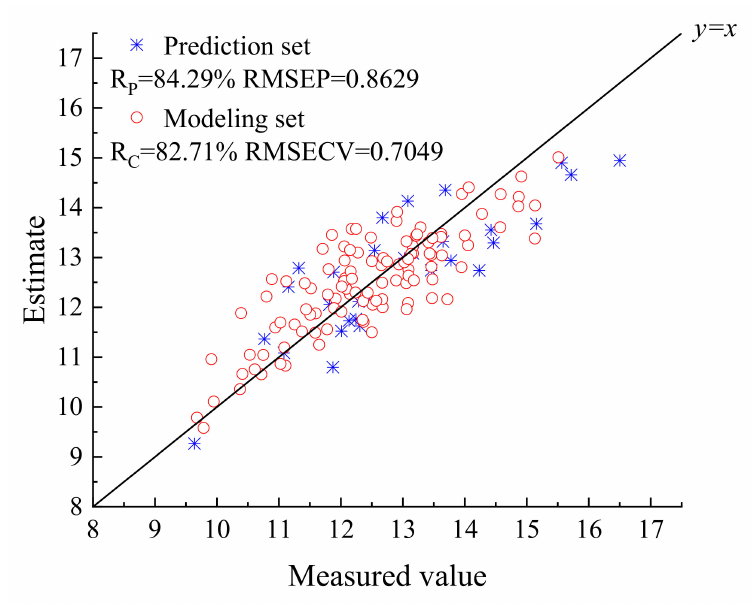
Figure 16. MCUVE–CARS–PLS model modeling set and prediction set results.